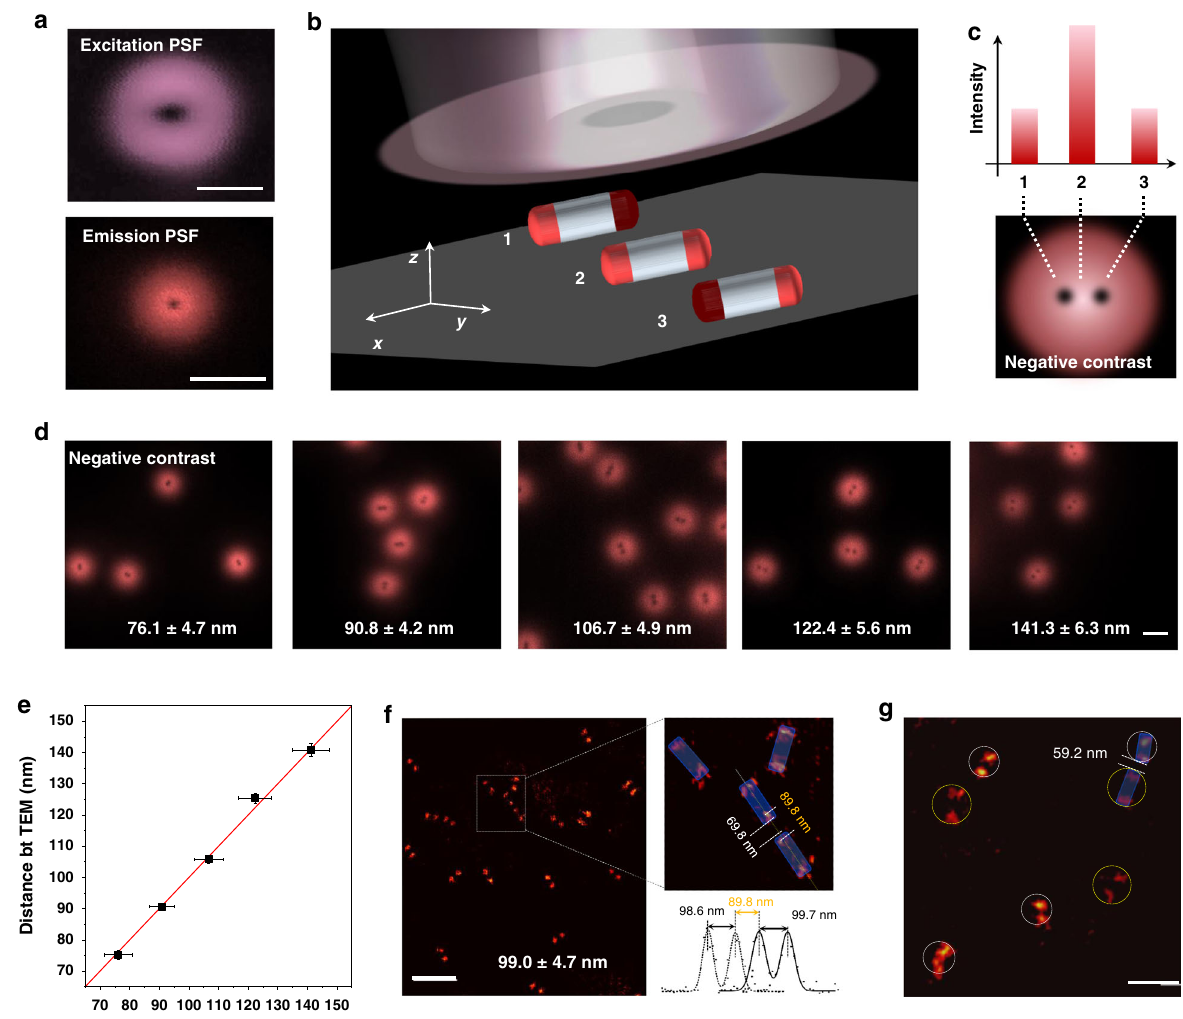
Fig. 2 Super-resolution imaging of nanorods with different length. a The pattern of the donut-shaped illumination of excitation point spread function (PSF) and the pattern of the resulted emission PSF after scanning across a single UCNPs. b Illustration of a process using a donut-shaped excitation beam to scan and resolve the heterogeneous structure of a single upconversion nanorod. c The corresponding luminescence intensities at the three typical positions to resolve the fi nal negative-contrast super-resolution image of a nanorod. d The raw data of negative-contrast super-resolution images of fi ve types of heterogeneous upconversion nanorods with tuneable lengths between the optically active components. e The average center-to-center distance and standard deviation of two actively doped segments of fi ve types of heterogeneous upconversion nanorods measured from TEM and super-resolution imaging, data are shown as the mean ± SD. f Super-resolution image of the high concentration nanorods with an active segmental distance of 99.0 nm. g Super-resolution image of the mixture of two types of nanorods with active segmental distances of 90 nm and 122 nm, respectively. Pixel sizes in d , f , and g are 10 nm. Scale bars in a , d , f , and g are 500, 500, 400, and 250 nm,